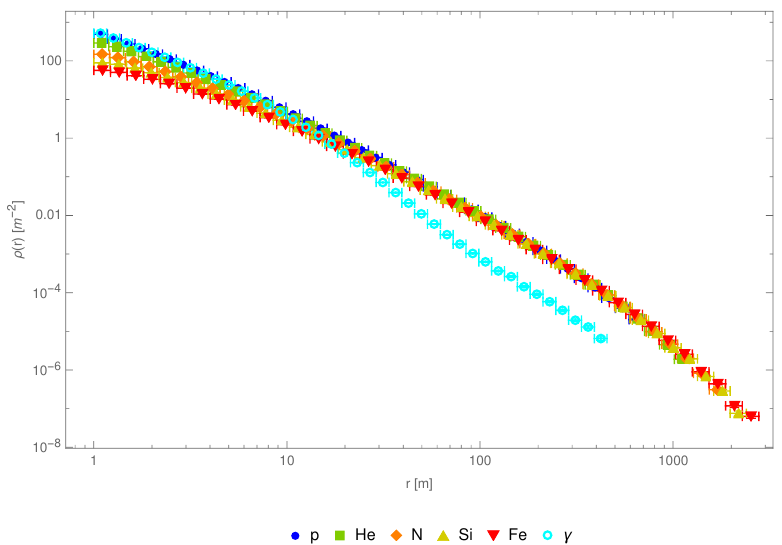
Figure 8. ρ ( r ) distribution of photons in cascades initiated by different primary cosmic-ray particles with energy E = 4000